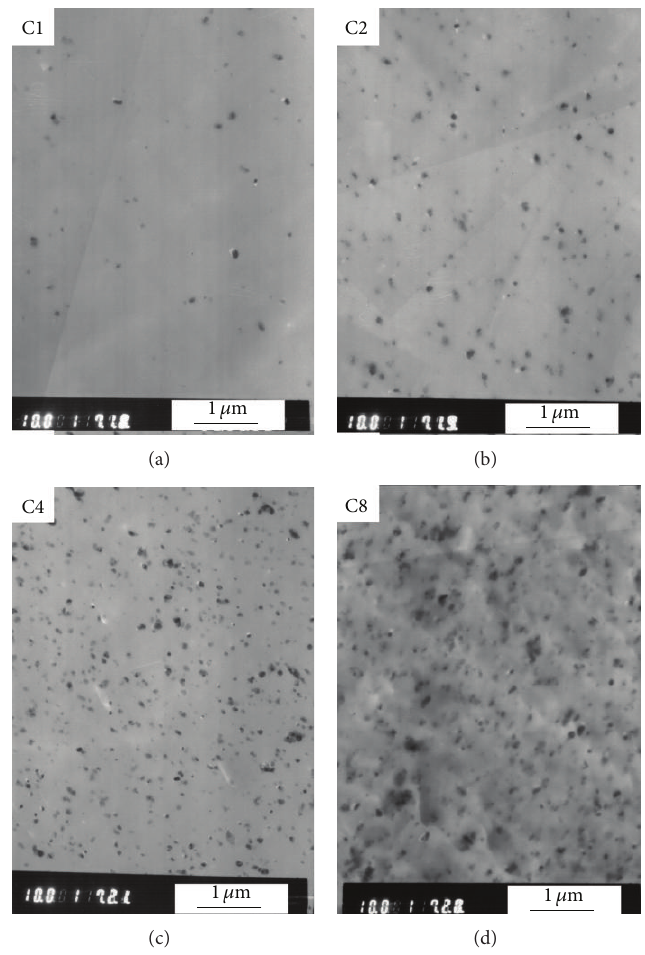
Figure 1: Transmission electron micrographs of nanocomposites C1, C2, C4, and C8. Table 1: Mechanical properties and heat distortion temperatures of different PTT/CaCO